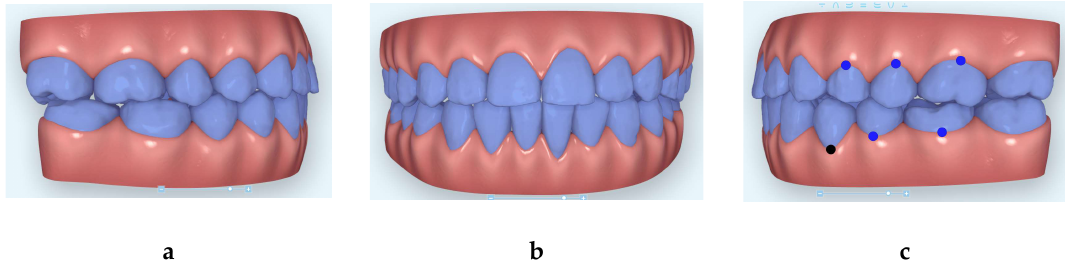
a a a Figure 7. Images of the beginning of final Clincheck ( a ): right side; ( b ) frontal view and ( c ) left side . Figure 7. Images of the beginning of final Clincheck ( a ): right side; ( b ) frontal view and ( c ) left Figure 7. Images of the beginning of final Clincheck ( a ): right side; ( b ) frontal view and ( c ) left side . Figure 7. Images of the beginning of final Clincheck ( a ): right side; ( b ) frontal view and ( c ) left side . Figure 7. Images of the beginning of final Clincheck ( a ): right side; ( b ) frontal view and ( c ) left side .